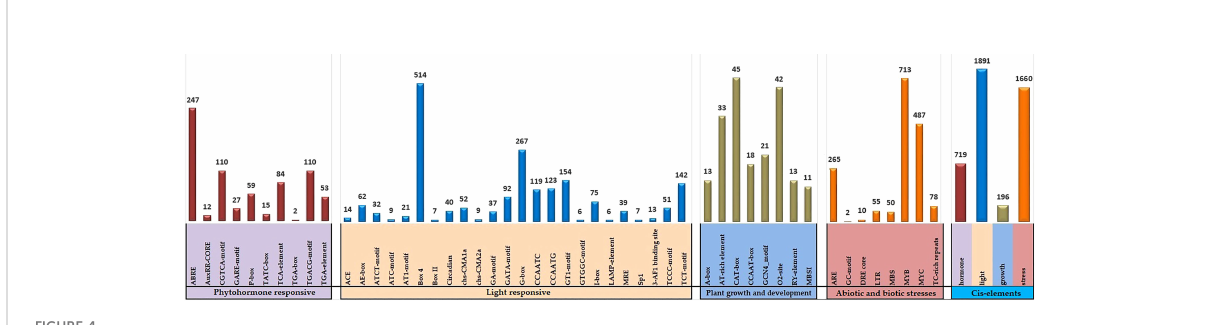
FIGURE 4 The number of cis-acting elements analyzed in the promoter region of GmGLK genes. A separate colored histogram shows the ratio of detected cis-regulatory components of each group.